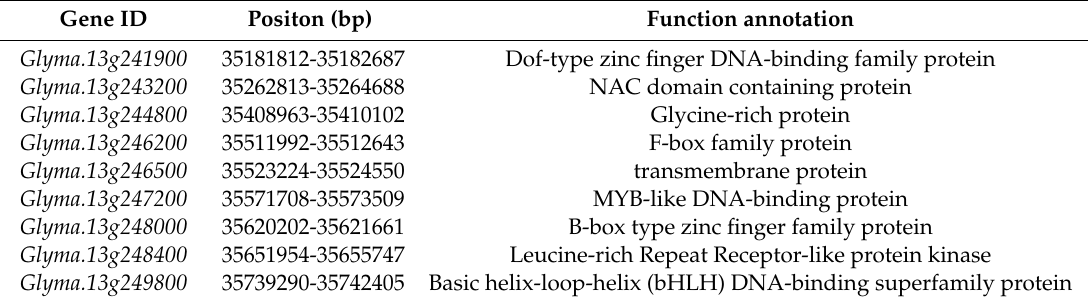
Figure 7. Relative expression levels of nine candidate genes associated with seed-flooding tolerance in tolerant genotypes (L018, L422, and L488) and sensitive genotypes (L217, L230, and L260) under 3 d flooding treatment. Table 4. Functional annotation and positions of nine candidate genes associated with seed-flooding tolerance in the candidate region on Chr.13.